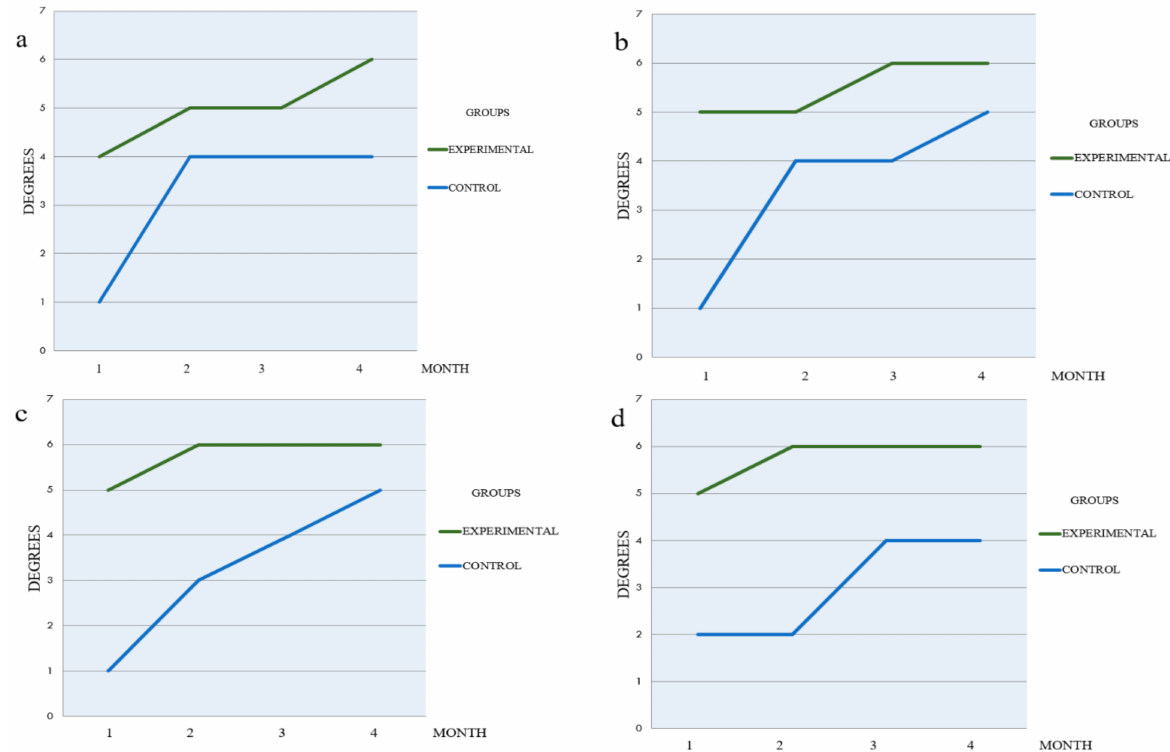
Figure 5. Quadrant Ro/BR 1-4, month evaluation ( a ) quadrant I ( b ) quadrant II ( c ) quadrant III ( d ) quadrant IV.